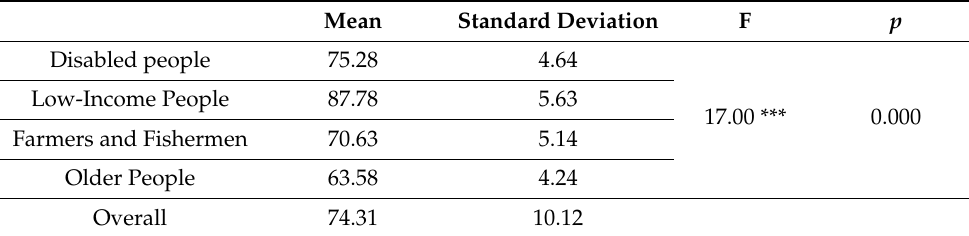
Table 6. Summary of Digital Divide of Four Classes.